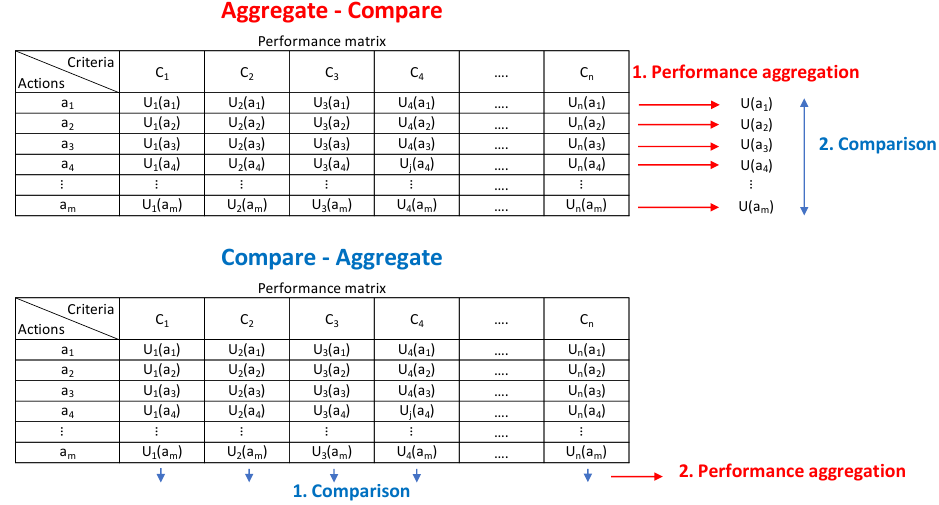
Figure 1. Schematic diagram of the “Aggregate–Compare” and “Compare–Aggregate” family.